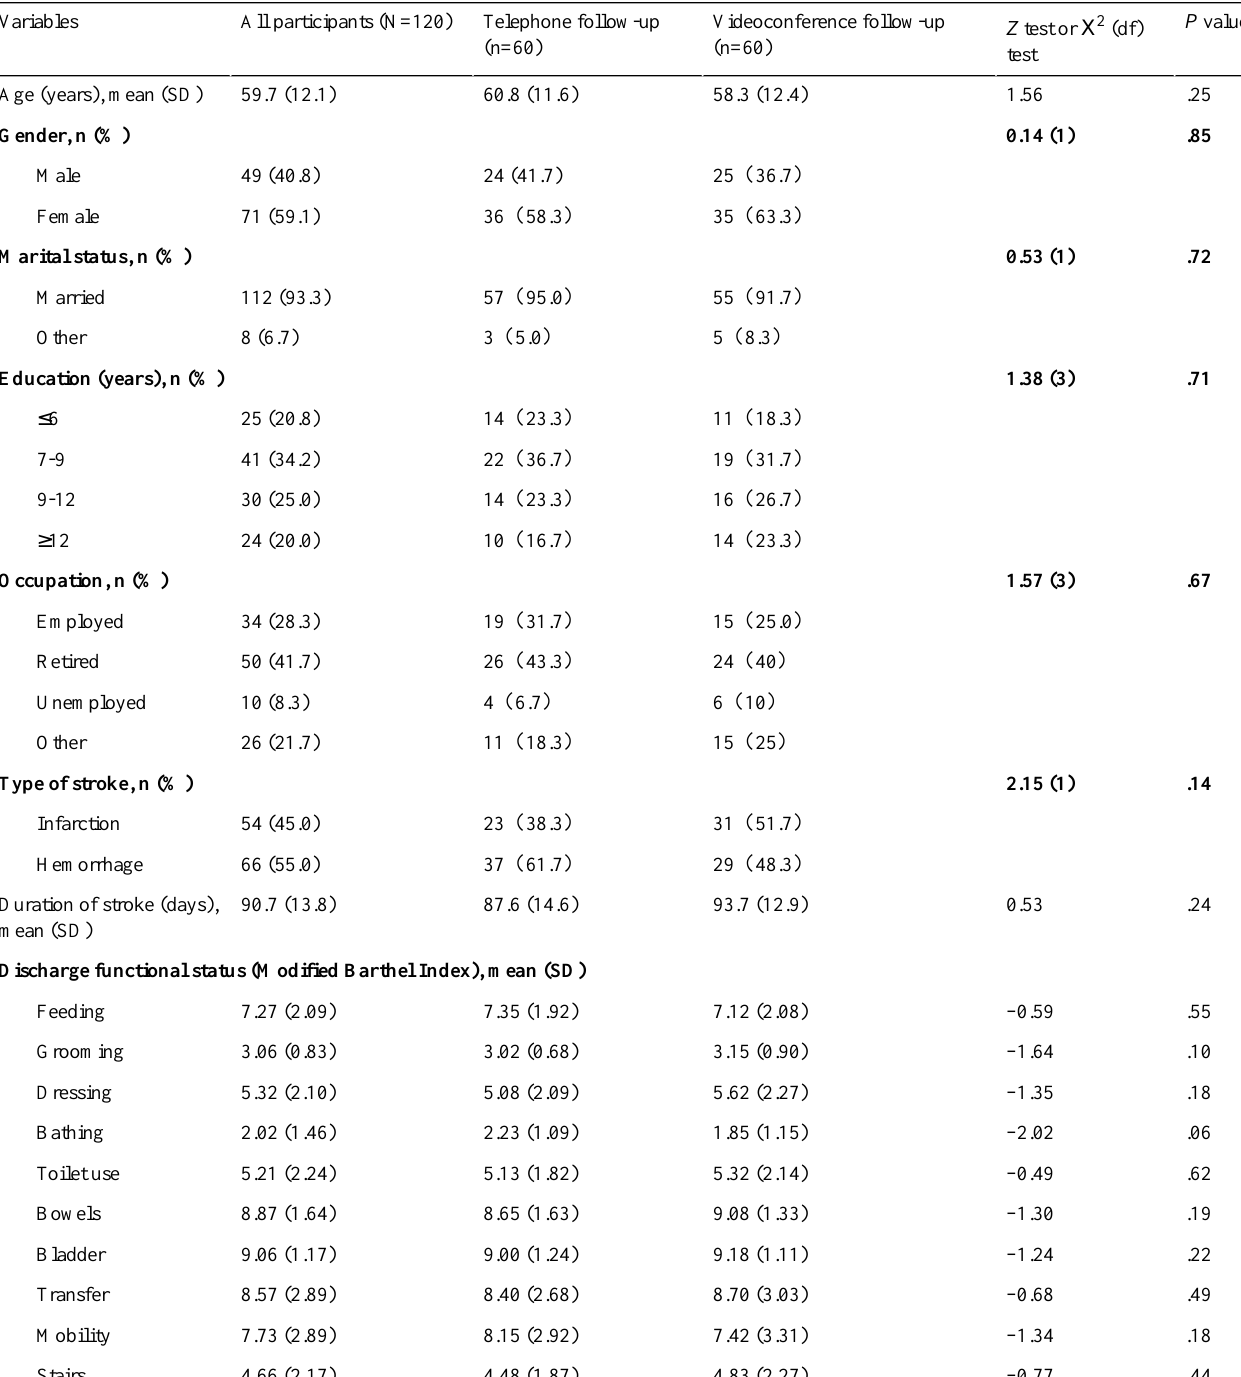
Table 1. Baseline characteristics of